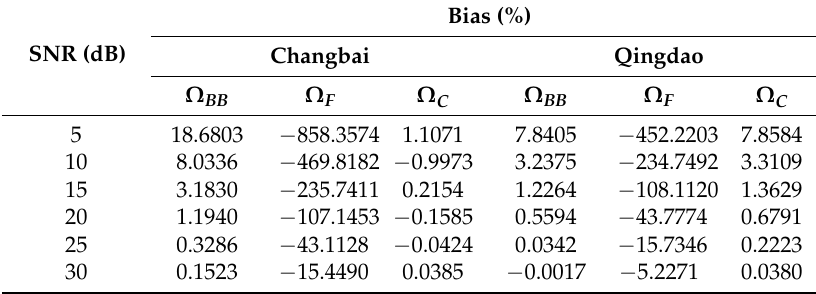
Table 2. Bias ( σ bias ) under the condition of system noise.